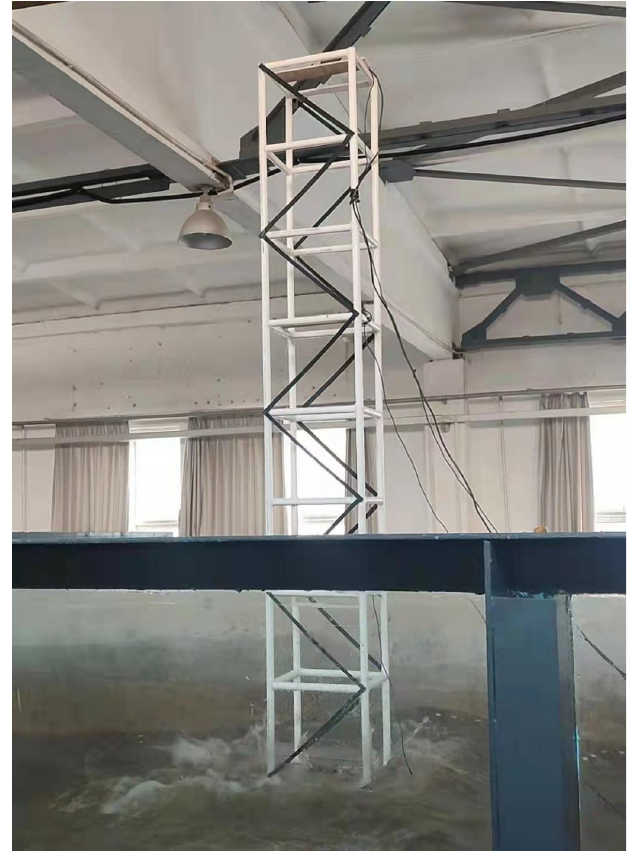
Figure 5. Photo after the preparation of model B.